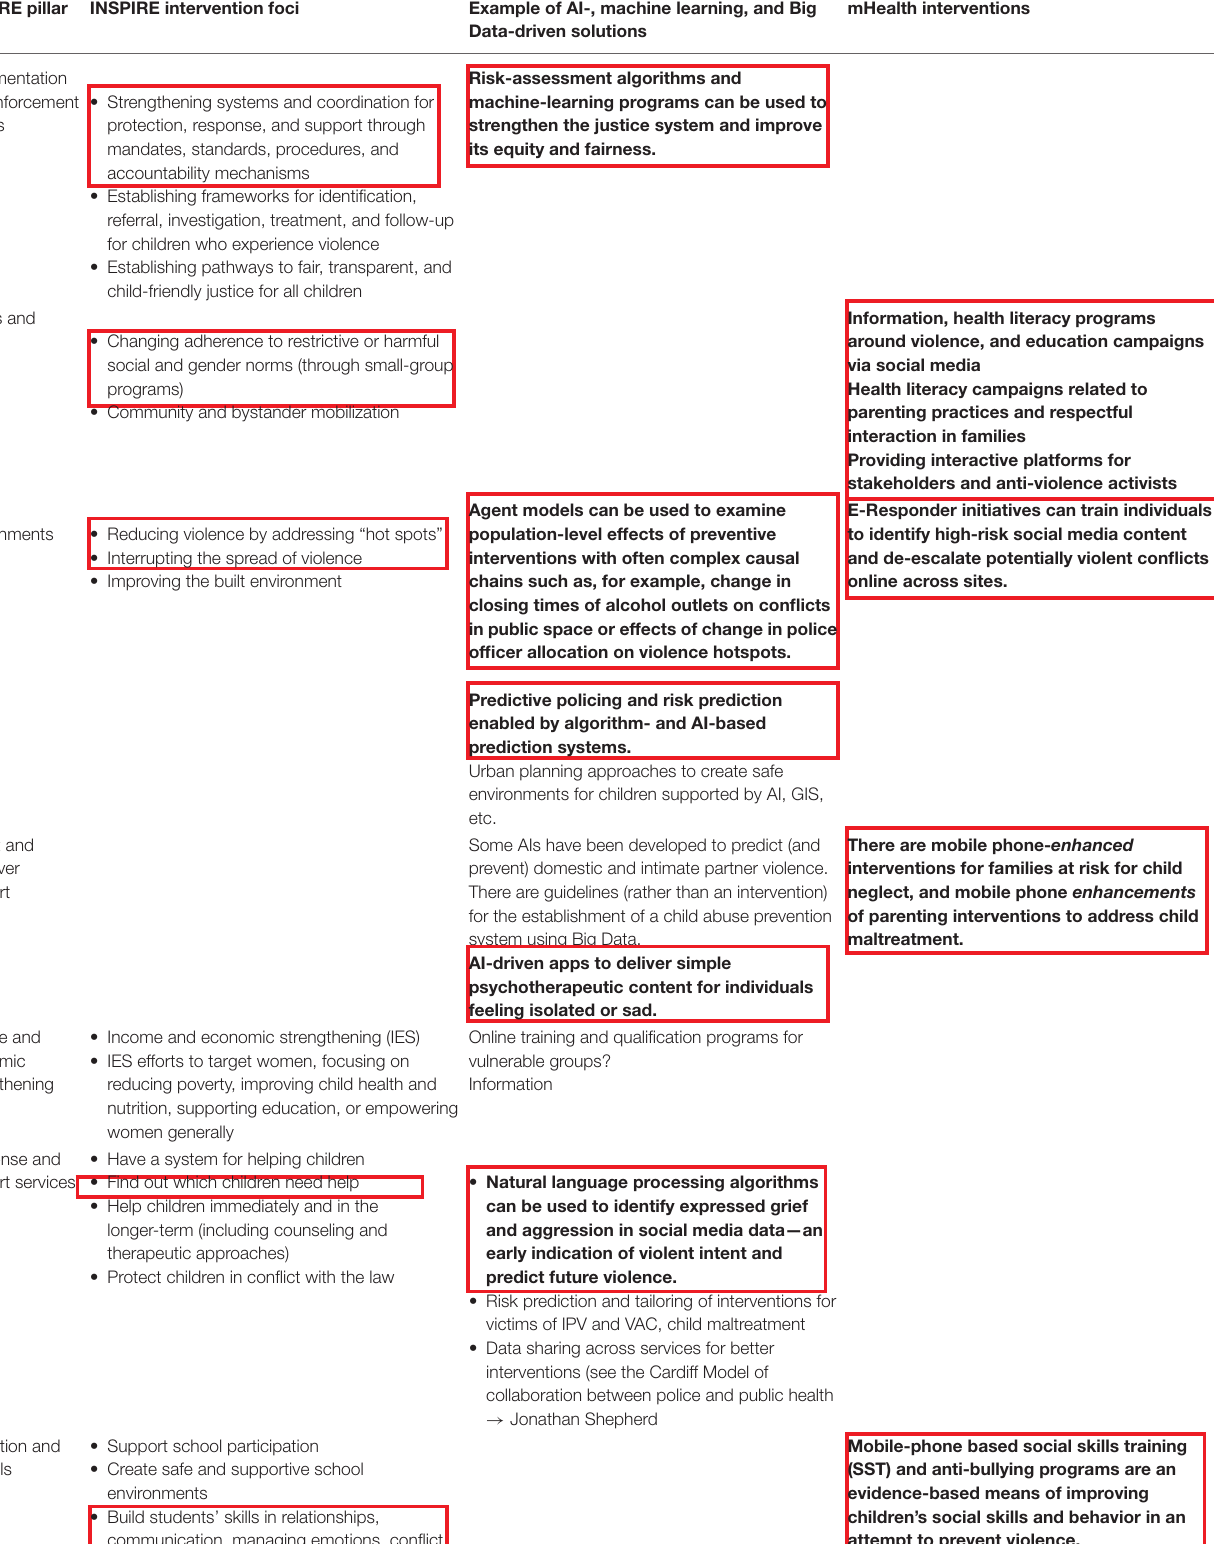
TABLE 3 | Mapping violence prevention priorities and possible AI, mHealth, and machine-learning solutions onto the INSPIRE objectives. INSPIRE pillar INSPIRE intervention